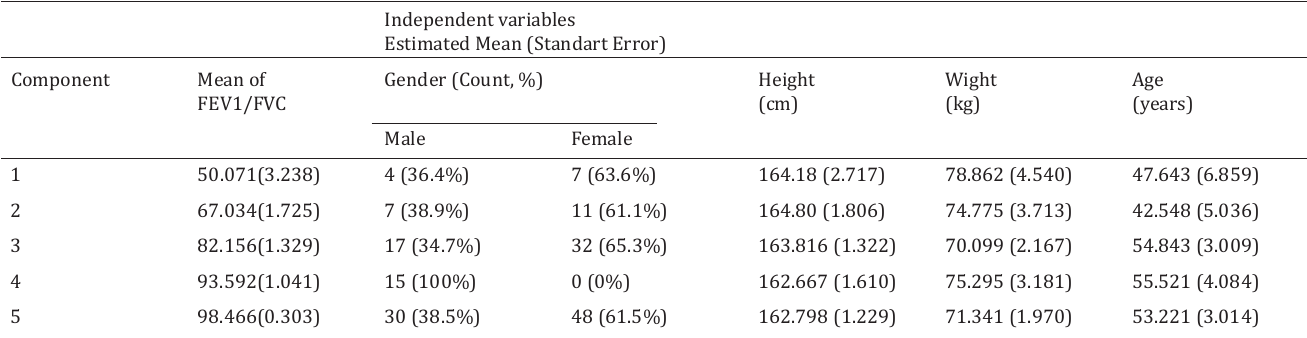
Means of variables according to components